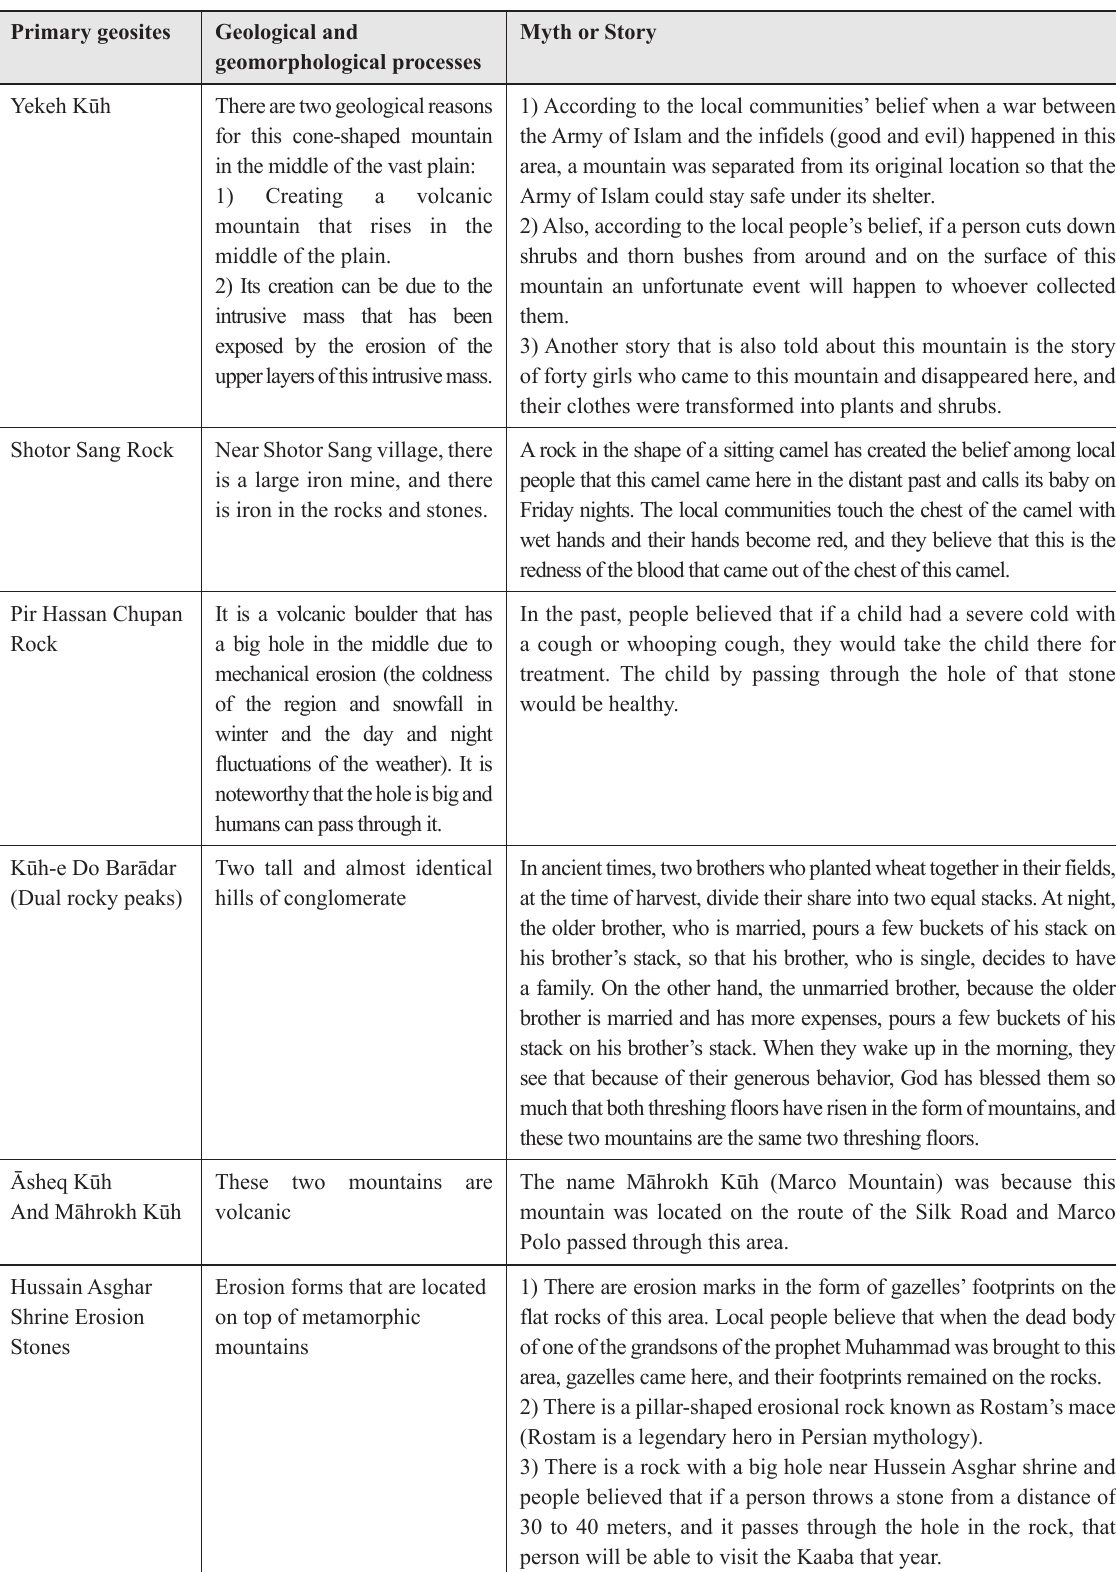
Table 1. Primary geosites with cultural geomorphology values in Neyshabur and Firuzeh Counties obtained from interviews and